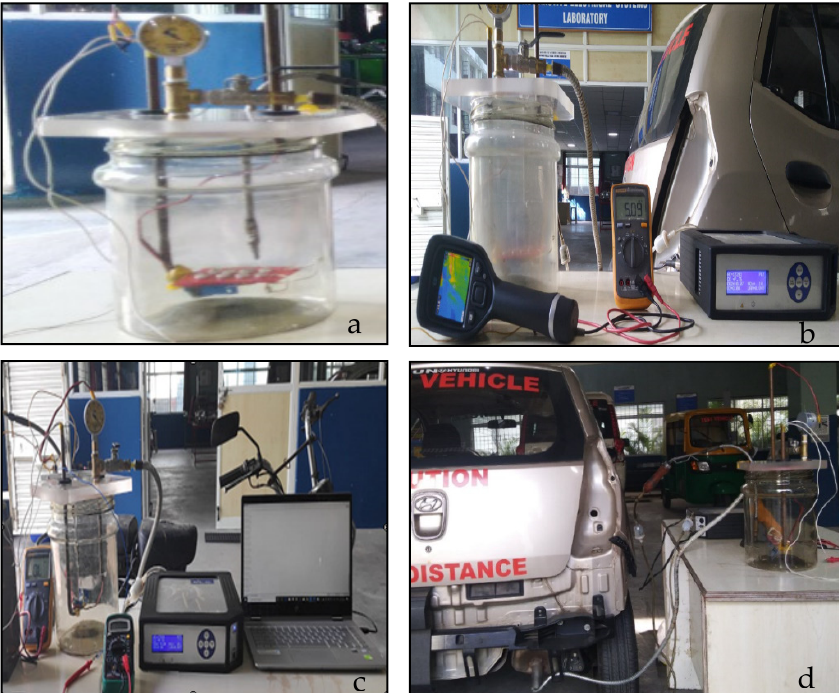
Figure 3. Experimental set-up for real-time sensor testing. ( a ) Sensor arrangement inside chamber with an exhaust gas analyser and a commercial CO sensor MQ-7. ( b ) Gas chamber with sensor arrangement connected to the measurement setup using external lead. ( c ) Data collection from chamber by the data acquisition system, continuously recording the values. ( d ) Test-vehicle engine connected to the inlet of the chamber.